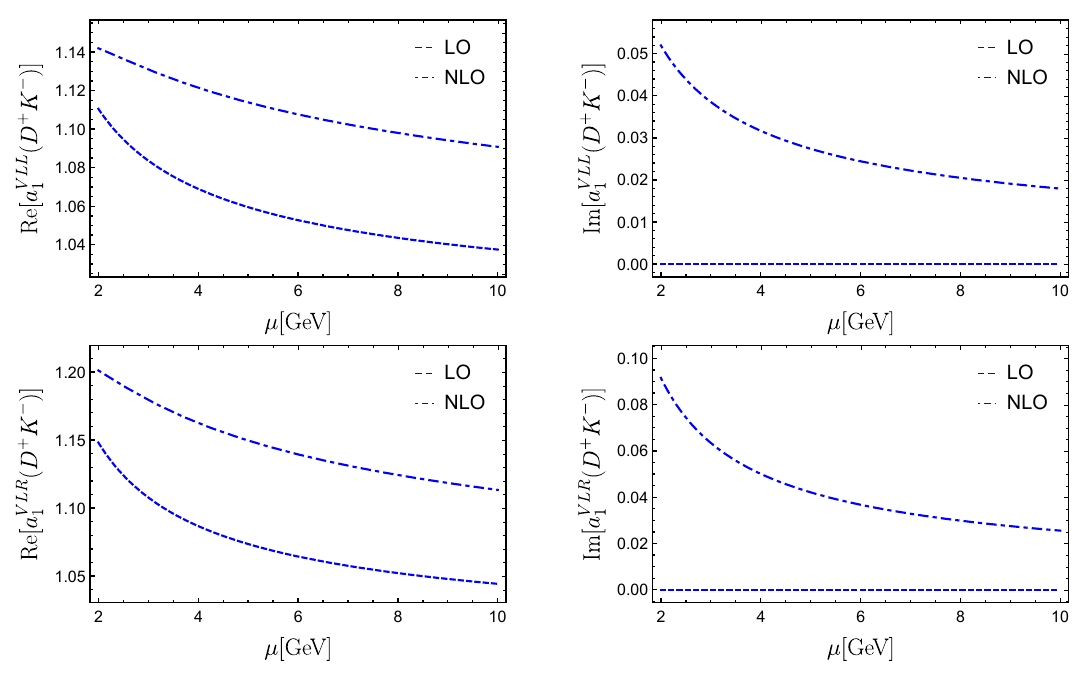
Figure 14 . Dependence of the efficient coefficients a V LL malization scale µ , both at the LO (dashed lines) and at the NLO order (dash-dotted